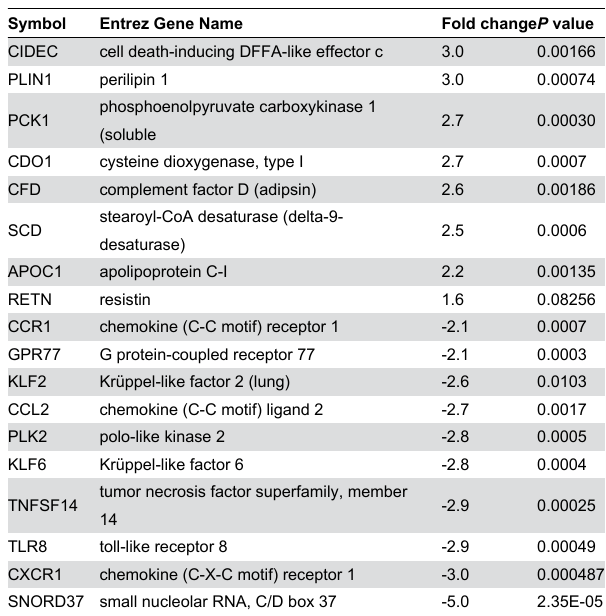
Table 12. Bone marrow adipocyte genes displaying greatest differences in leptin deficient mice compared with age matched high fat diet (HFD) fed